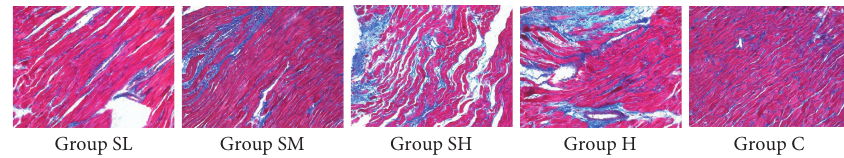
Figure 2: Masson staining of atrial